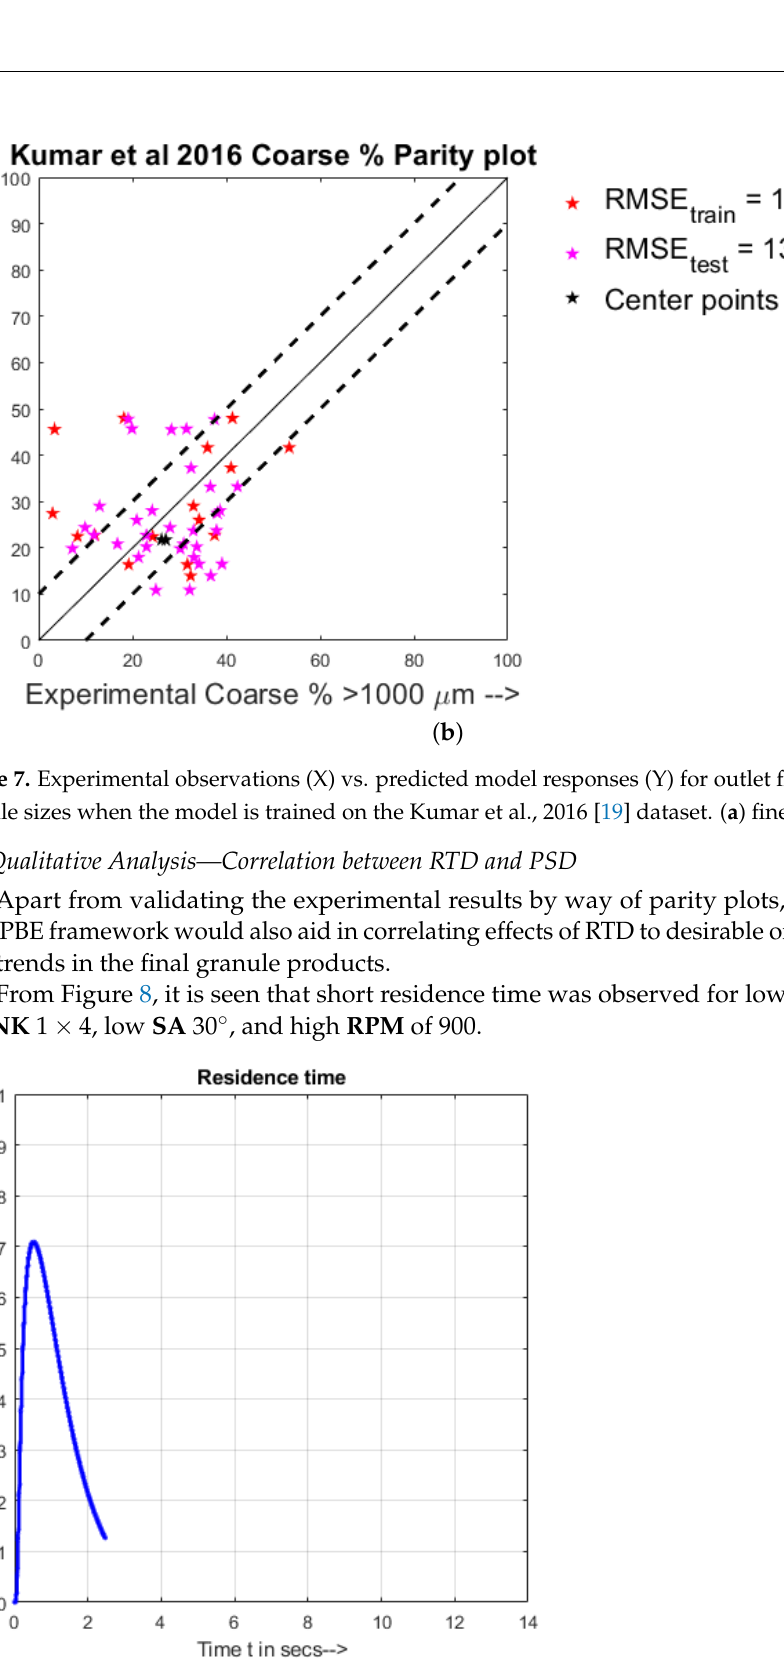
Figure 8. RTD trend obtained from a PBM pulse tracer study for an unfavorable granulation case from the experimental DOE of Kumar et al., 2016